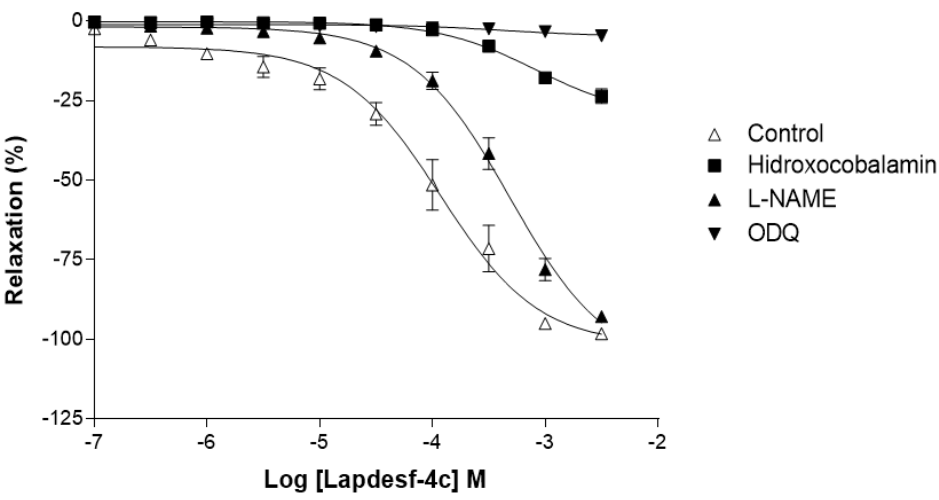
Figure 4. Concentration–effect curve for Lapdesf-4c (E+) in the presence of hydroxocobalamin, L -NAME, and ODQ to study the involvement of NO release pathway in vasodilation. Data are expressed as percentage of aortic relaxation. Each experiment was performed on rings prepared from different